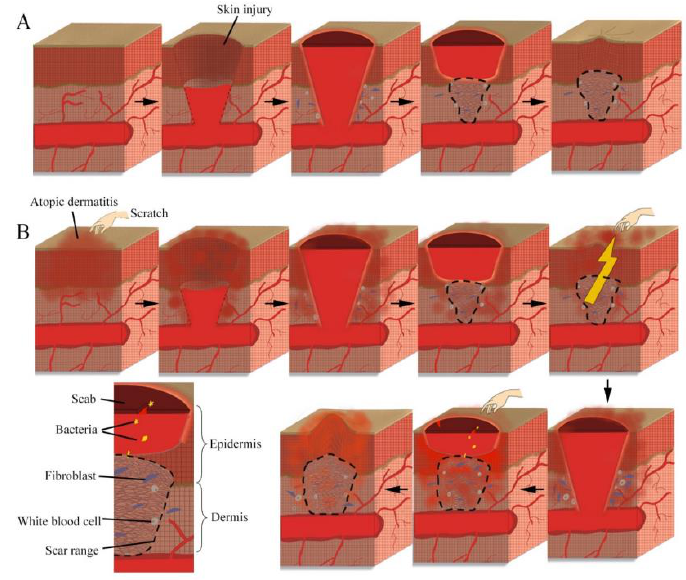
Figure 2. Schematic diagram of epidermal keratinocyte differentiation. Structure of the epidermal barrier and how the CLE is formed, in detail.